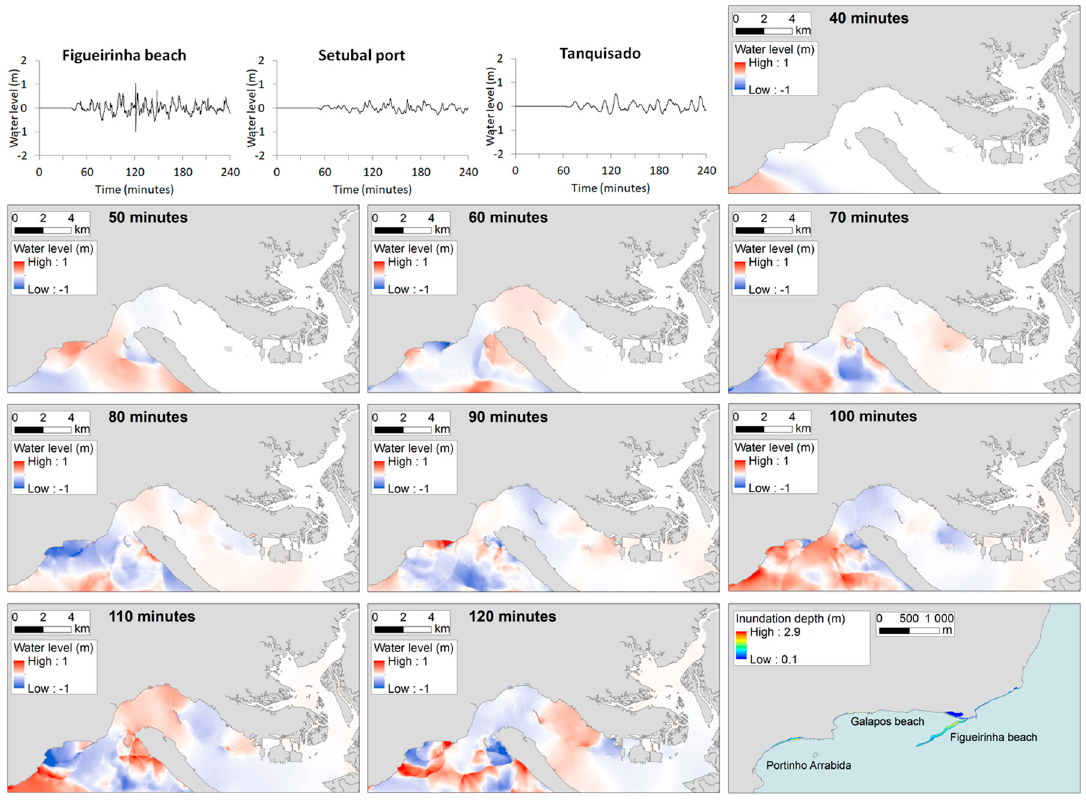
Figure 7. Water level waveforms, snapshots, and inundation depths of the 1969 tsunami.